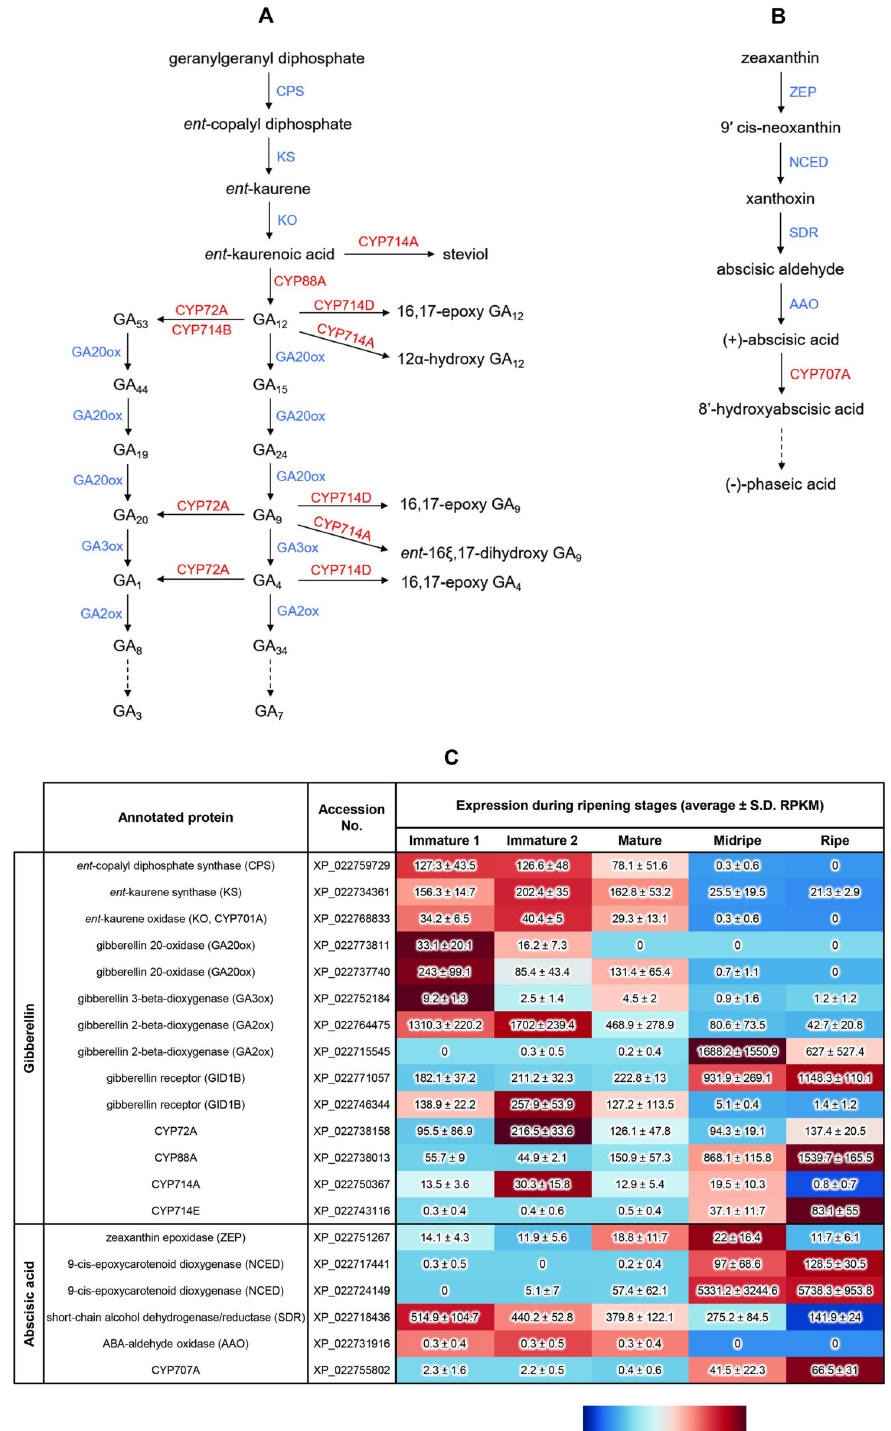
Fig 5. Proposed reaction and RNA-seq based expression profiles involved in phytohormone biosynthesis. (A) Gibberellin biosynthetic pathway driven by CYP72A, CYP88A, and CYP714 in durian. Enzyme abbreviations: CPS, ent -copalyl diphosphate synthase; KS, ent -kaurene synthase; KO, ent -kaurene oxidase; GA2ox, gibberellin 2-oxidase; GA3ox, gibberellin 3-oxidase; GA20ox, gibberellin 20- β -oxidase. Cytochrome P450s are indicated in red, whereas other enzymes are indicated in blue. (B) Proposed catalytic pathway of abscisic acid driven by CYP707A in durian.